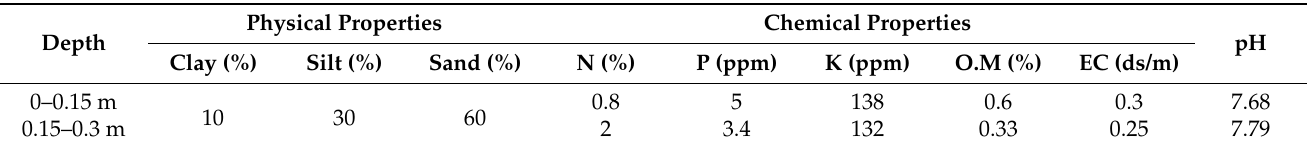
Table 4. Some physical and chemical properties of the experimental